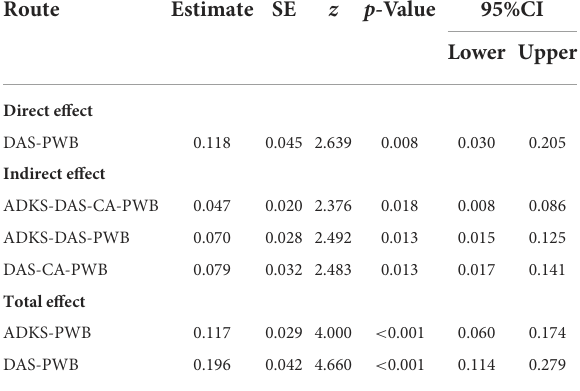
TABLE 3 Path coefficients of the modified